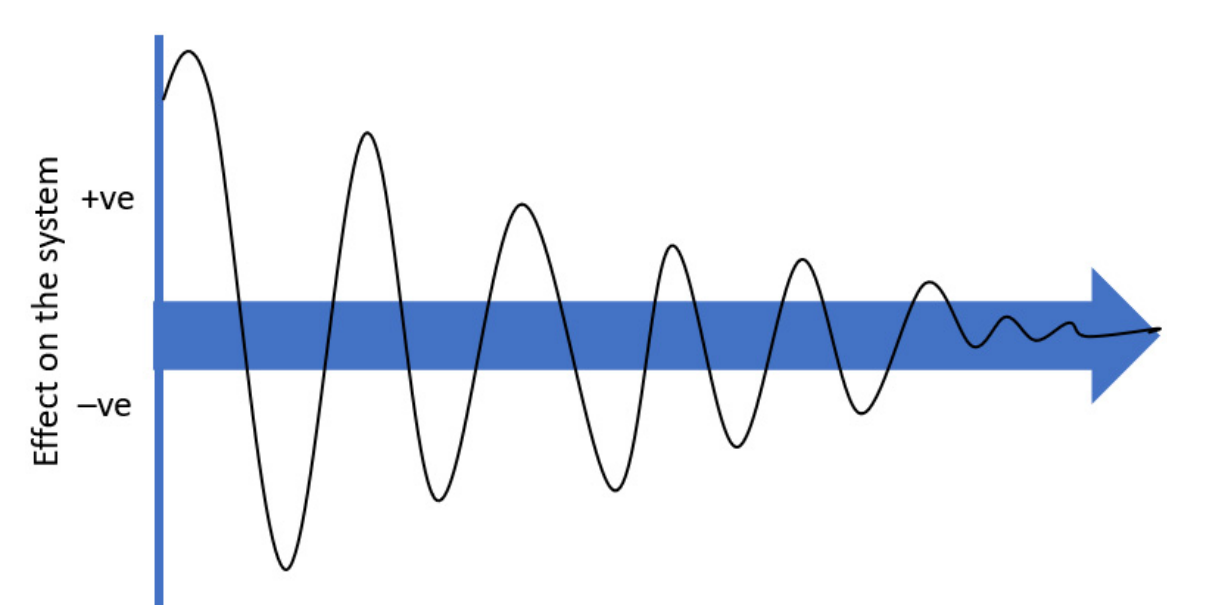
Figure 3. Theoretical depiction of the effect from a change to a single industry moderator, causing the overall effect on the entire system to oscillate until equilibrium is re-established between all three industry moderators (economics, horse biology and social licence).